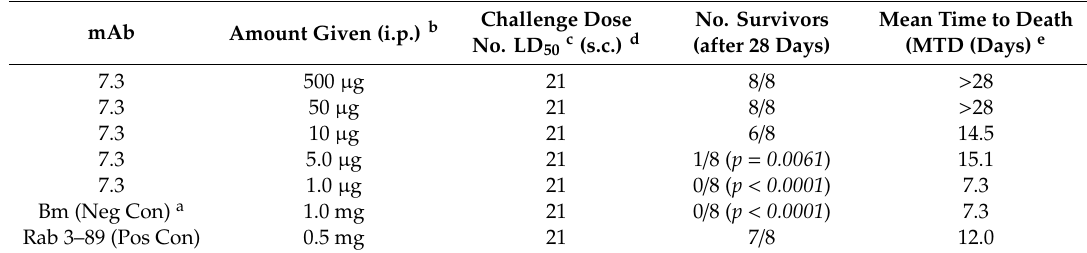
Table 1. Protection of BALB / c mice by Y. pestis anti-V monoclonal antibody (mAb) 7.3 from Y. pestis CO92 in a bubonic plague